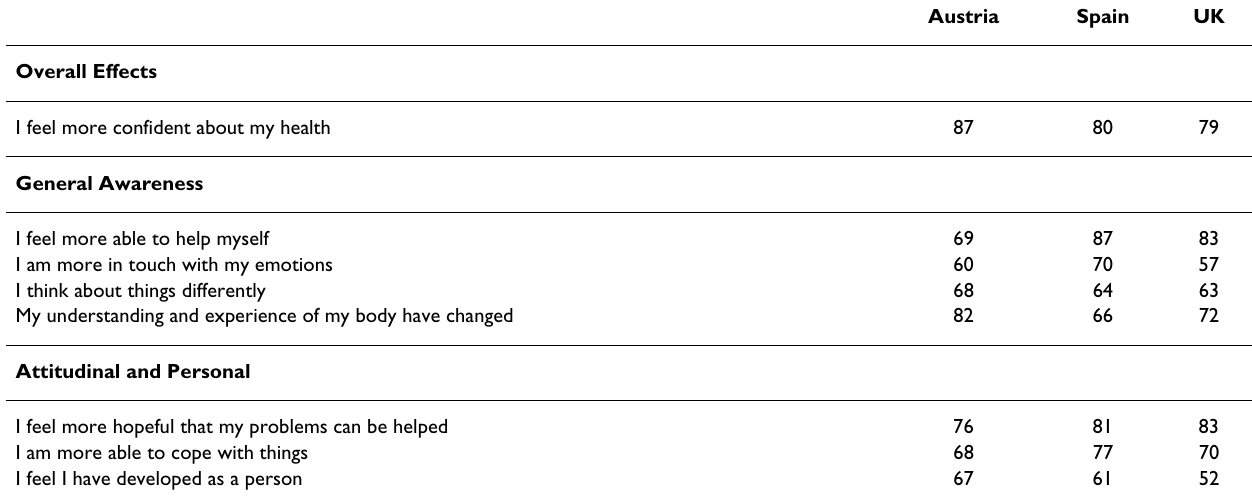
Overall Effects